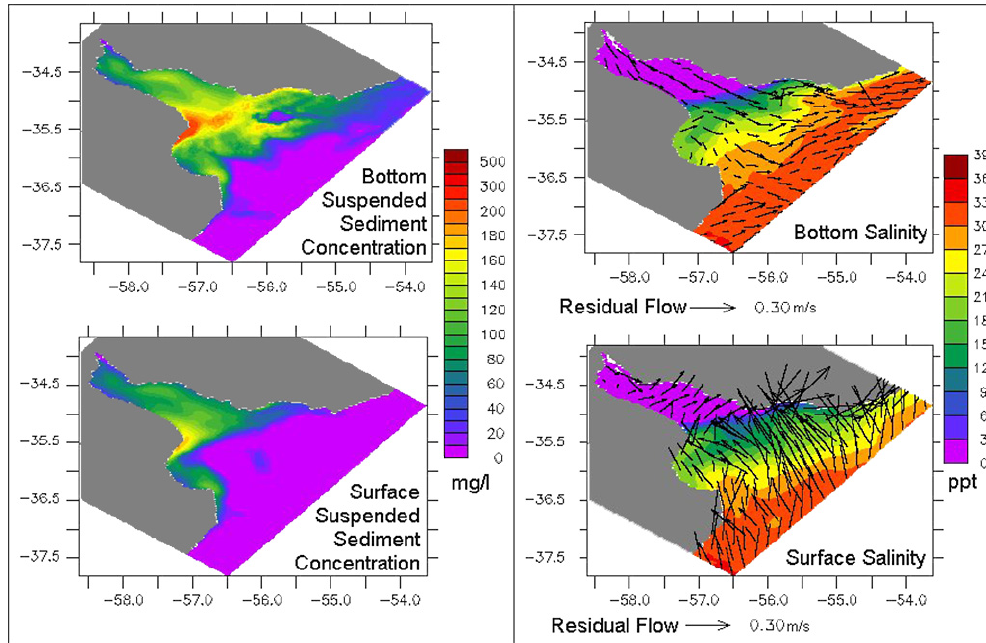
Fig. 5. Mean computed fields obtained over the 13–14 August 2010 period (storm conditions): bottom suspended sediment concentration (upper left panel), surface suspended sediment concentration (lower left panel), bottom salinity and residual flow (upper right panel), surface salinity and residual flow (lower right